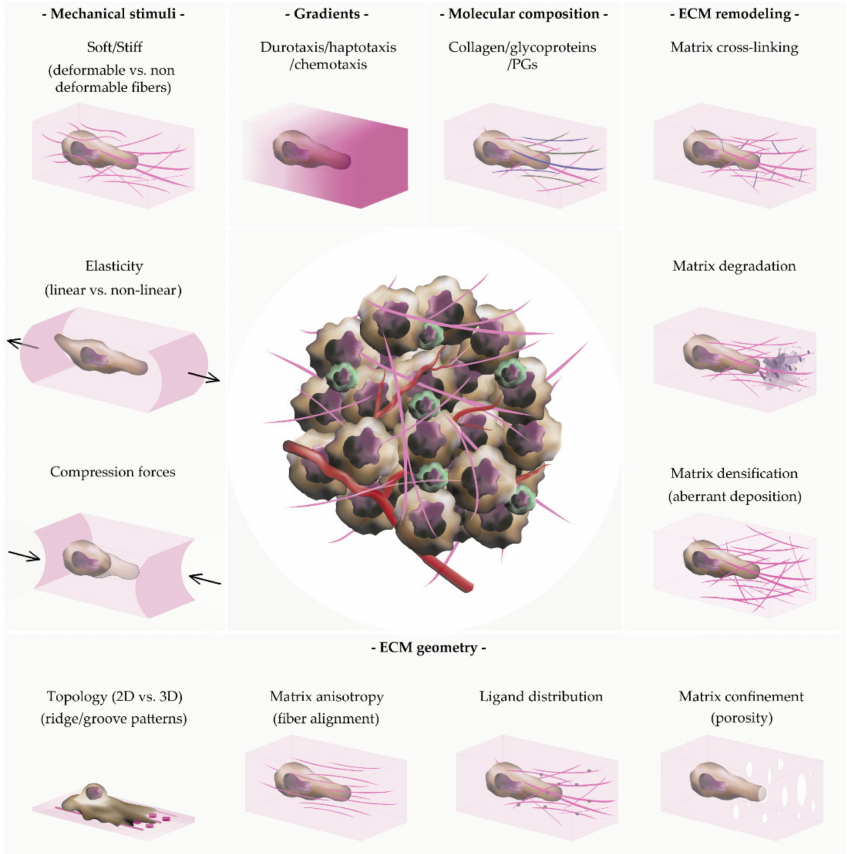
Figure 2. Tumor cell dissemination and metastasis are influenced by the physicochemical properties of ECM and the interactions between cells and matrix. The ECM properties fall into the following categories: molecular composition, mechanical stimuli, ECM geometry, and matrix remodeling. Namely, the content and balance of the ECM constituents -fibrous proteins, glycoproteins, or PGs- determines the topology and mechanical properties of the lattice, as well as the cellular response, via modulation of the surface receptors -e.g., integrins- or the reservoir of growth factors. Mechanical stimuli include different physical cues that affect the deformability of the fibers e.g., strain stiffening effect, the